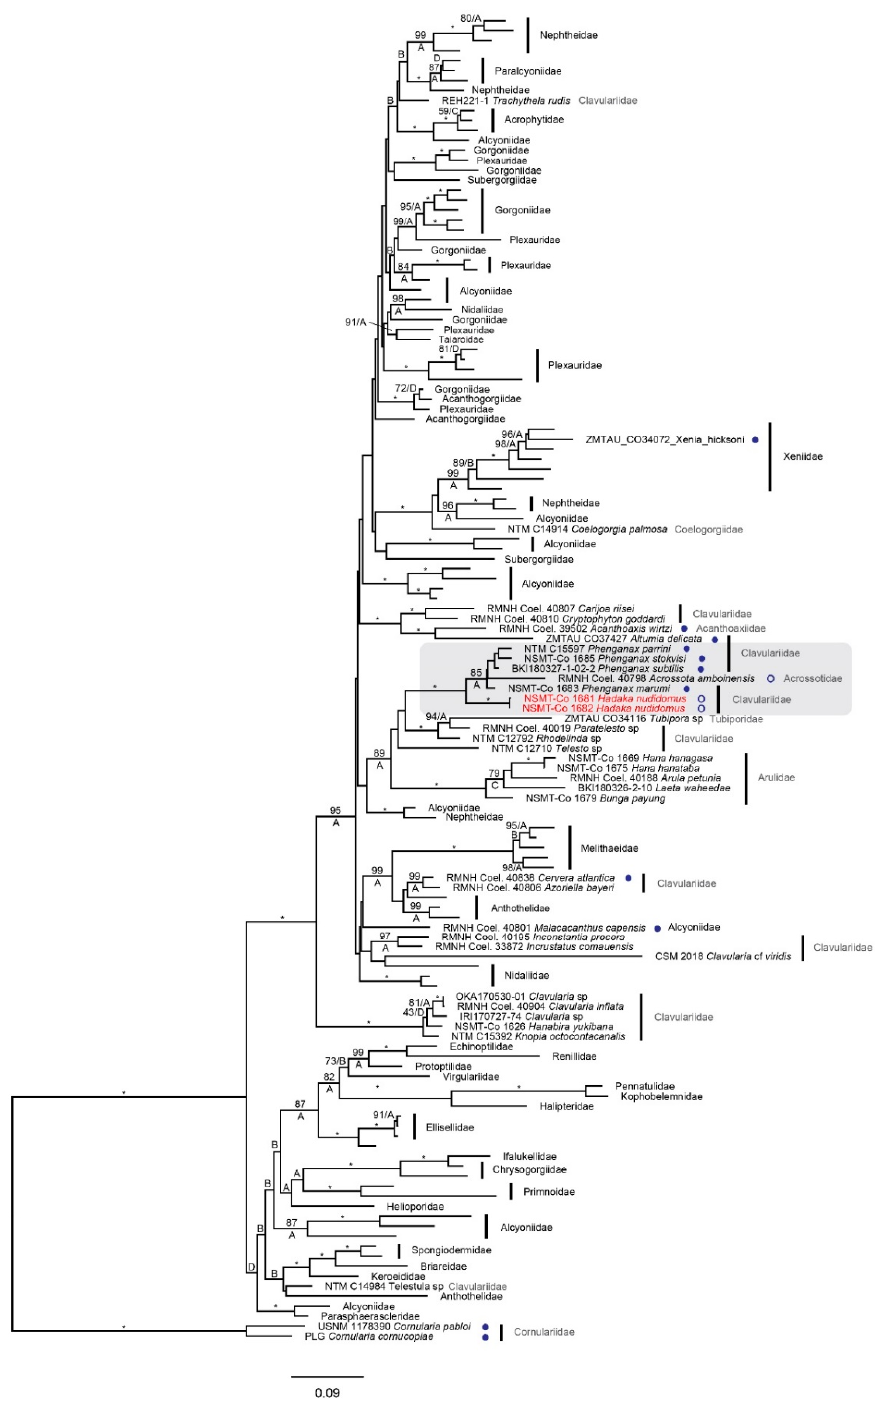
Figure 3. Phylogenetic relationships among 122 octocoral genera (total n = 144), including two species, Hadaka nudidomus gen. nov. et sp. nov. (highlighted red), collected at Iriomote and Okinawa Islands using the combined 28S rDNA + COI + mtMutS dataset. The best maximum likelihood tree is shown, with values at branches representing bootstrap probabilities (shown when >70%; top/left) and Bayesian posterior probabilities (shown when >0.80; bottom/right; A = 1.00, B = 0.95–0.99, C = 0.90–0.94, D = 0.80–0.89). * represents 100%/1.00 for both analyses. Non-stoloniferous families are shown with family classification only and stoloniferous families are highlighted in grey. Sclerite-free species are indicated with a blue dot. Species that are both sclerite-free and lack free pinnules are indicated with a blue circle. Cornularia spp. were used as outgroup.